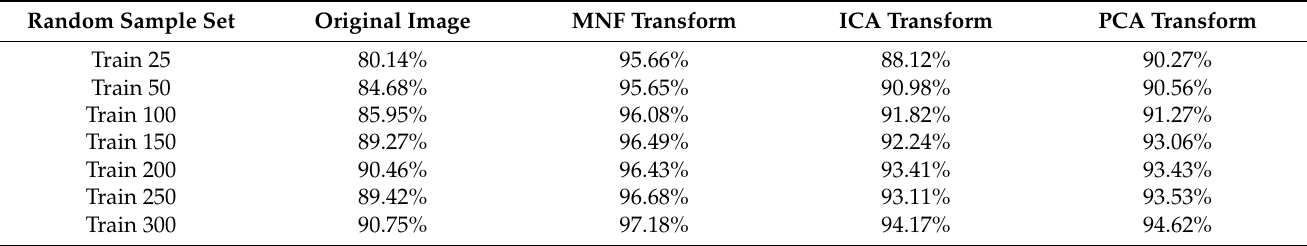
Table 1. RF classification accuracy evaluation of random sample sets in the Longkou area.